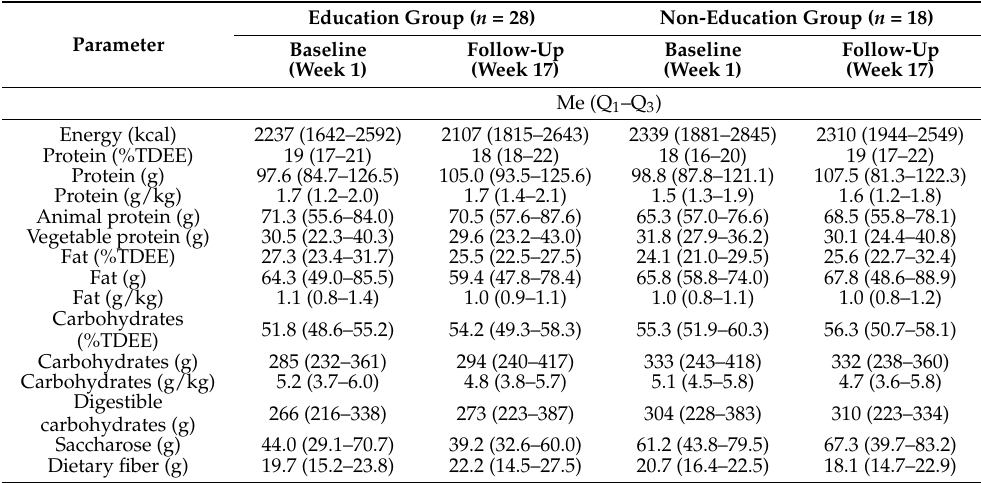
Table 2. Pre and post intervention changes in macronutrient